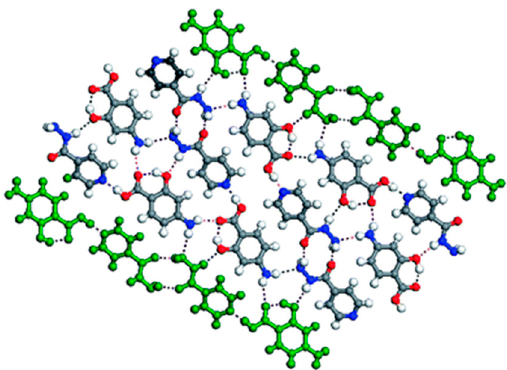
Figure 5. Hydrogen bond interaction present in INH-PAS cocrystal showing finite tetramer motif highlighted in green. Adapted with permission from CrystEngComm , 2011, 13 , 4358–4364. Copyright 2011, The Royal Society of Chemistry.